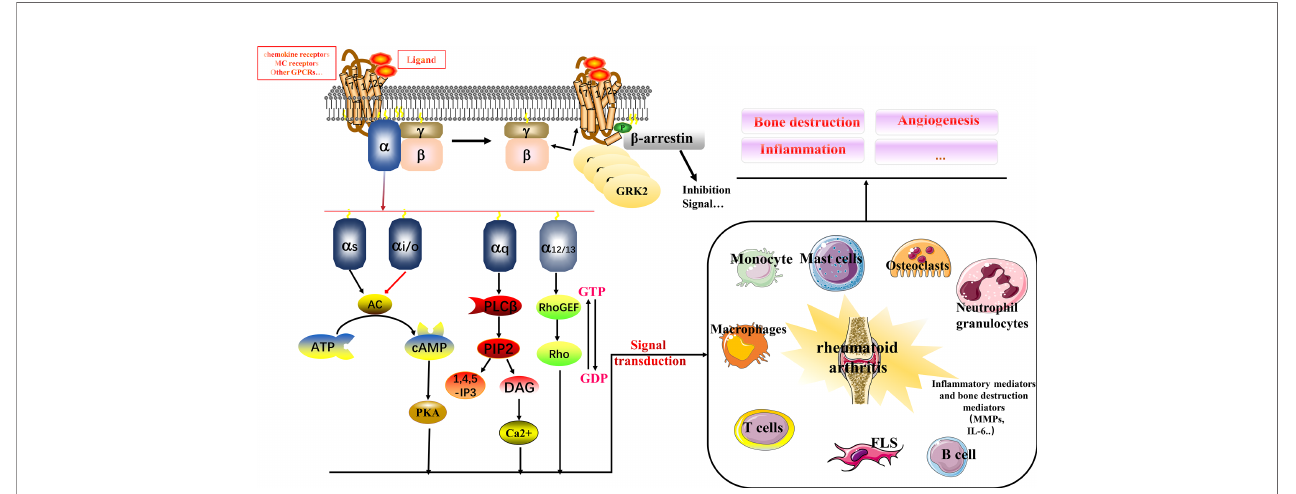
FIGURE 1 | Relationship between multiple GPCRs and RA. GPCRs signal through the abg subunit of heterotrimeric G proteins. In response to ligand signals, GTP binds to the G a subunit, and G bg dissociates to form a dimer for downstream signaling, binding to biological mediators. GRK2 is a kinase that phosphorylates activated GPCRs, making them a high-af fi nity substrate for the binding of the uncoupling protein arrestin. Arrestin binding abolishes ( “ arrests ” ) G protein-mediated signaling. The binding of GRK2 to G bg recruits cytosolic GRK2 to the plasma membrane, where the activated receptor is located. This is its primary function. It can also inhibit G bg -mediated signaling by sequestering G bg , which is a secondary effect. GPCRs interact with immune cells in RA to in fl uence multiple mechanisms including bone destruction, in fl ammation, and angiogenesis.